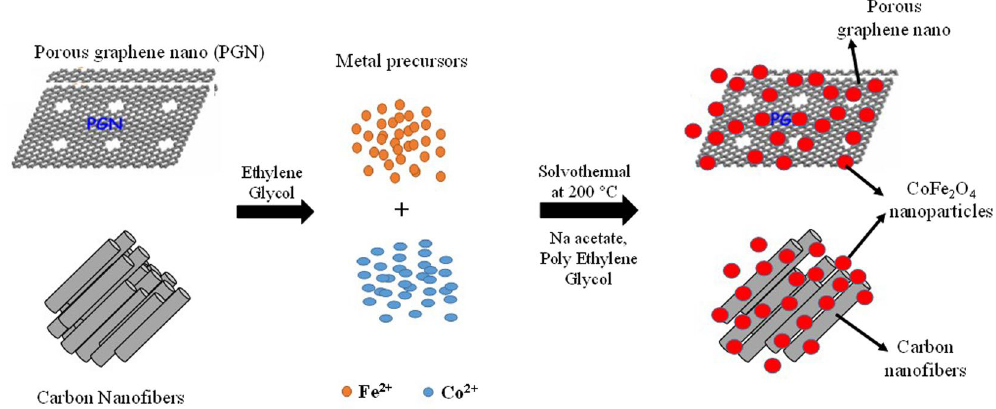
Figure 9. Schematic representation of synthesis process for PG-C and CNF-C